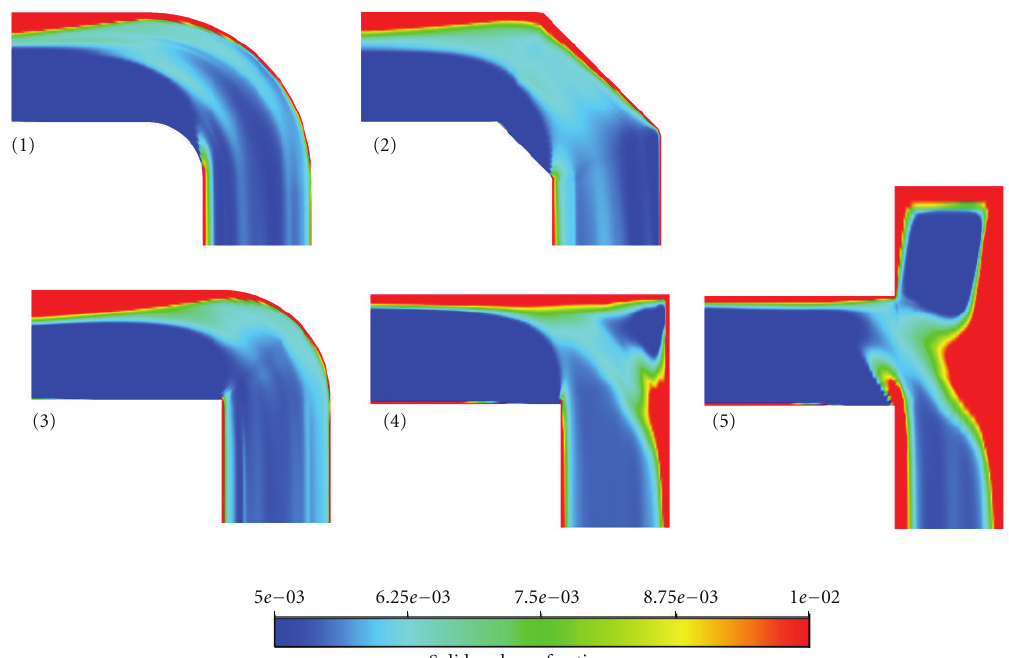
Figure 8: Solids volume fraction profiles at the